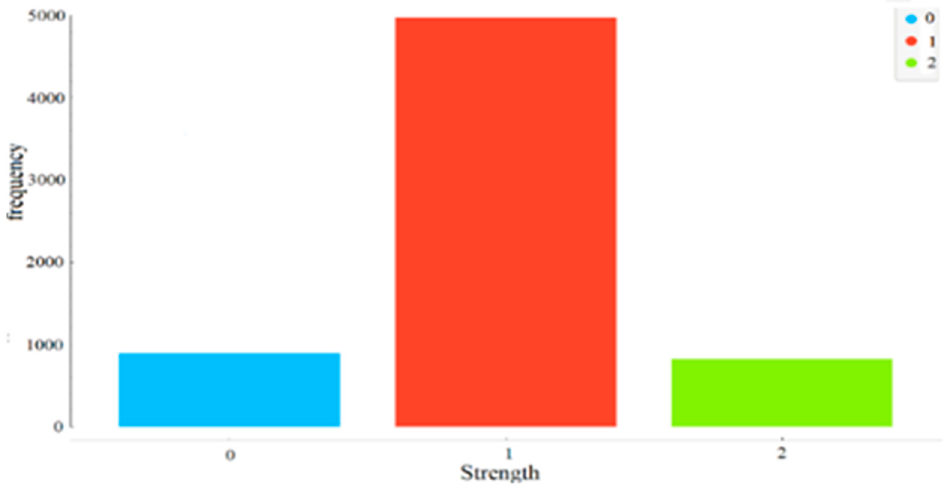
Figure 2. Percentage distributions of password strength [32].